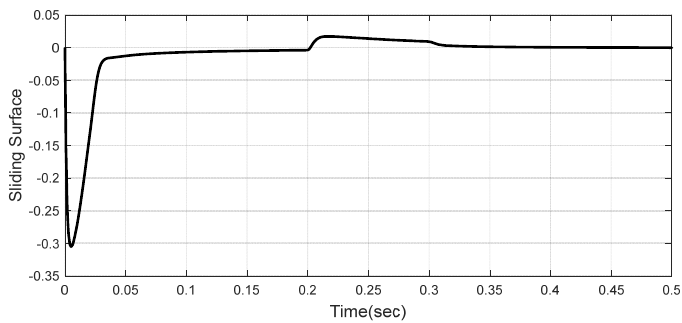
Figure 30. Sliding surface in the presence of measurement noise.